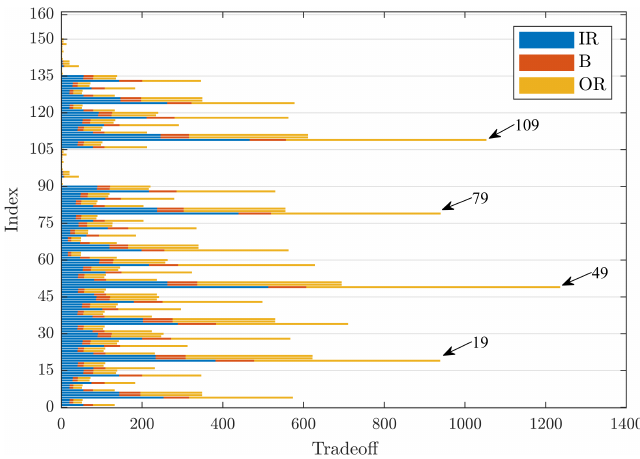
Figure 7. Comparison of TO values for defects of size 0.021 in. Table 3. Parameters required to maximise the sum of TO values for every defect location at varying defect diameters.